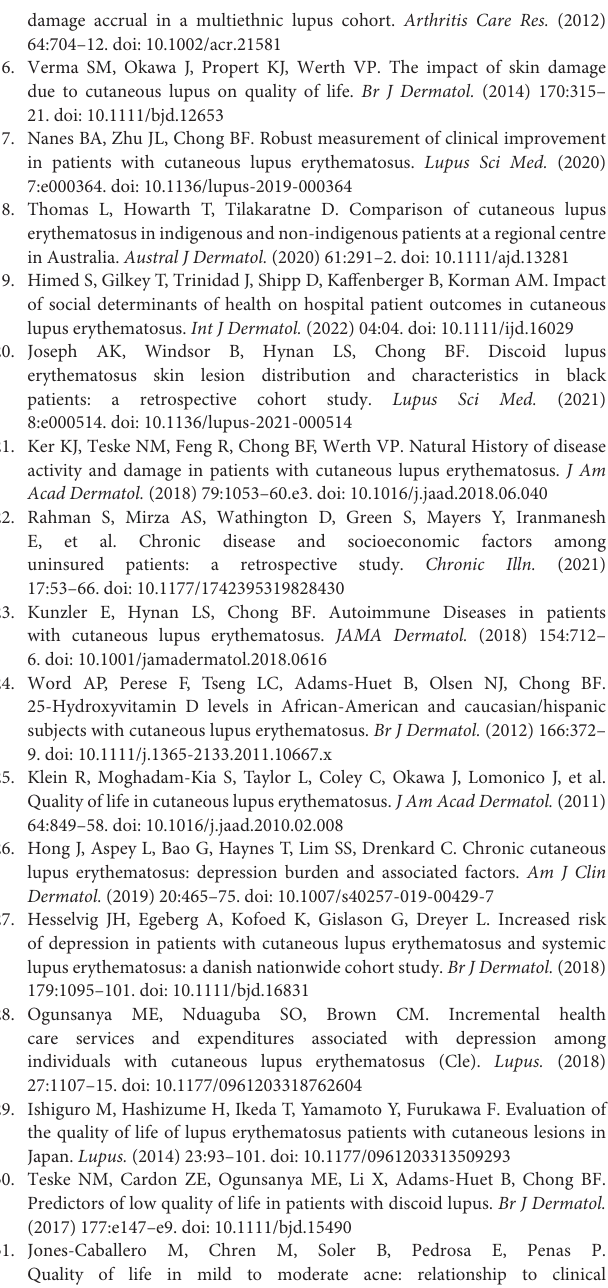
Supplementary Figure 1 | Study selection and screening methods used in present study. Figure was adapted from the PRISMA Flow Diagram 2020 V1. Inclusion criteria included studies with cohorts of CLE patients (with or without SLE) whose primary outcome included CLE diagnosis frequency, CLE disease outcomes or health-related quality of life. Exclusion criteria included non- English